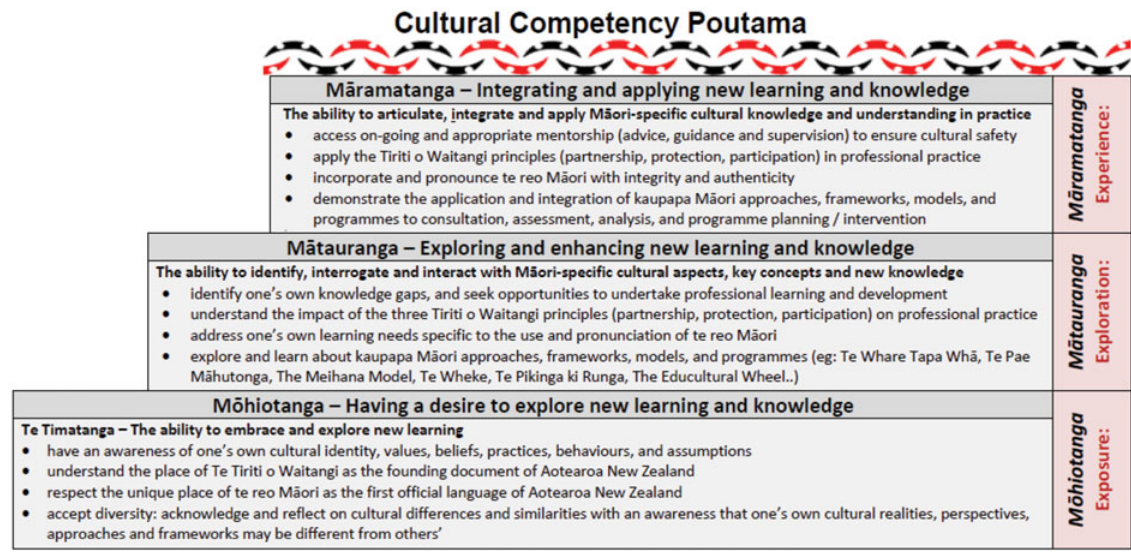
He Poutama Whakamana: A Framework to Guide Cultural Competency (Macfarlane,